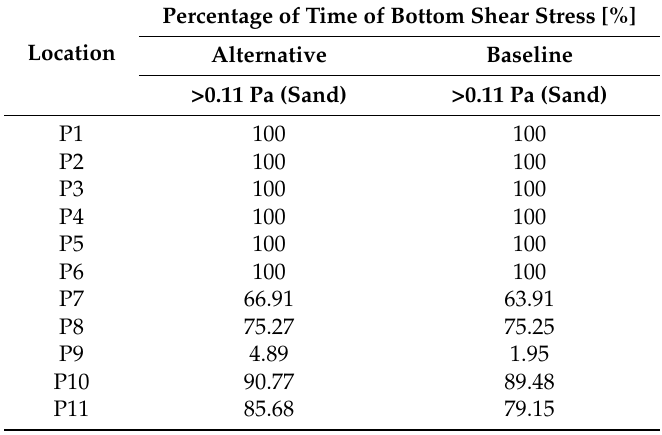
Table 3. Bed shear stress response for all